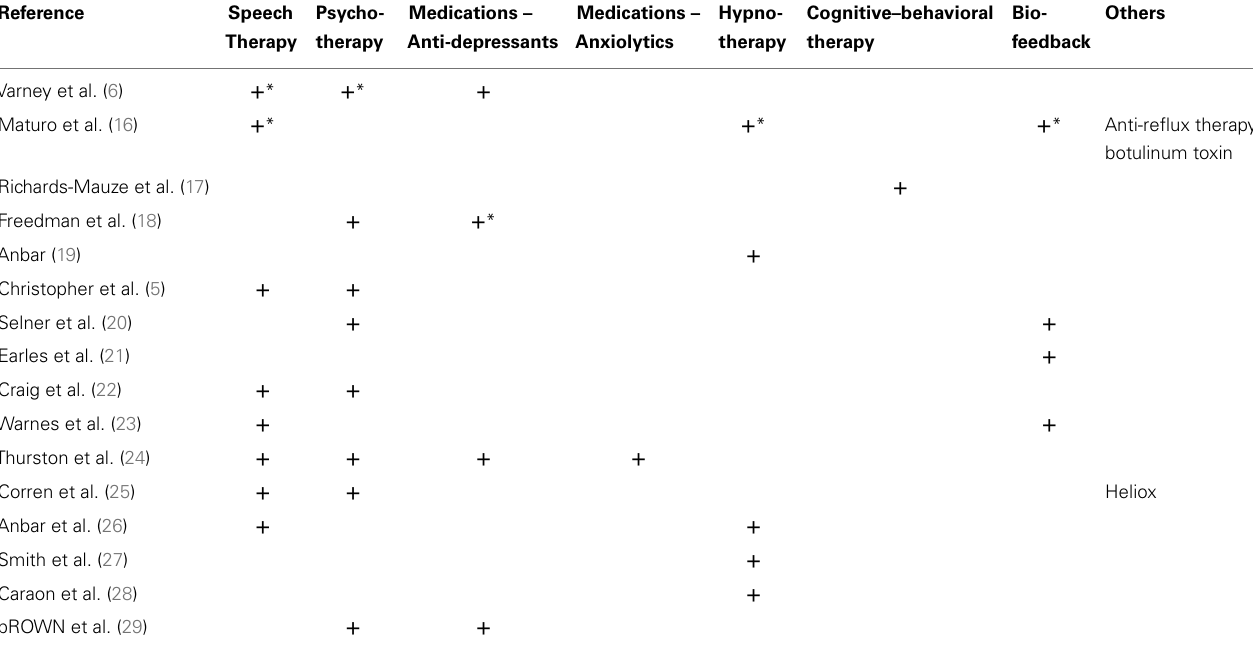
Table 2 | Use of different treatment modalities in patients withVCD undergoing psychological interventions